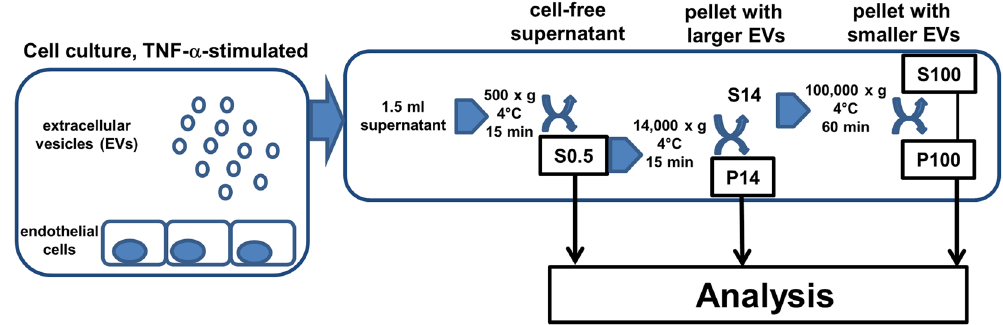
Figure 1. Differential centrifugation of EC culture supernatants. In order to remove the residual cells and cell debris, cell culture supernatants from TNF- α -stimulated HUVEC were initially centrifuged at 500 × g to gain a cell free supernatant (S0.5). Thereafter, centrifugation of the S0.5 at 14,000 × g pelleted the larger vesicles such as shedding microvesicles and apoptotic bodies (P14), while smaller EVs remained in the supernatant. Finally, this supernatant was subjected to ultracentifugation at 100,000 × g, resulting in a pellet (P100) containing EVs enriched in exosomes and a supernatant free of vesicles